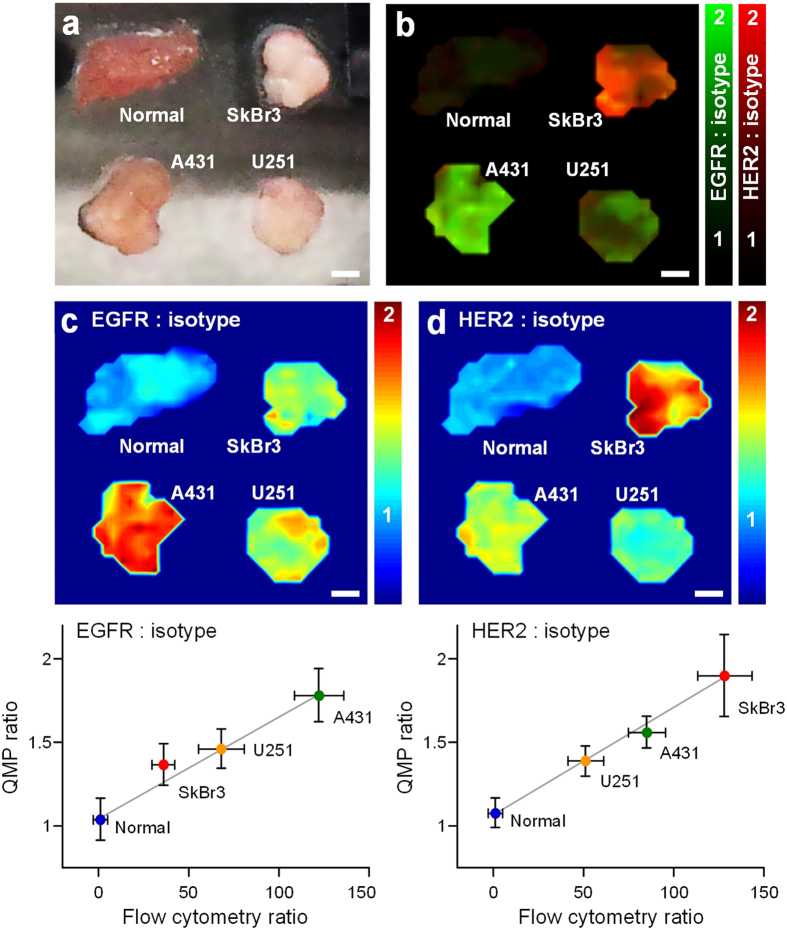
QMP imaging, with 0.5-mm spatial resolution, of tumor-xenograft specimens stained with a three-flavor NP mixture (EGFR-NPs, HER2-NPs and isotype-NPs). (a) Photograph of resected tumor xenografts and normal tissue. (b) A multiplexed QMP image generated by overlaying the ratiometric images of EGFR-NPs/isotype-NPs (plotted with a green colormap) and HER2-NPs/isotype-NPs (plotted with a red colormap). Images showing the concentration ratio of (c) EGFR-NPs/isotype-NPs and (d) HER2-NPs/isotype-NPs. The bottom plots show the correlation between the QMP ratio of a particular tissue specimen (in c,d) and the corresponding fluorescence ratio (targeted NP vs. isotype NP) from flow-cytometry experiments with the cell lines used to generate the various tumor xenografts (Supplementary Fig. S2). R > 0.98. Scale bars represent 2 mm.